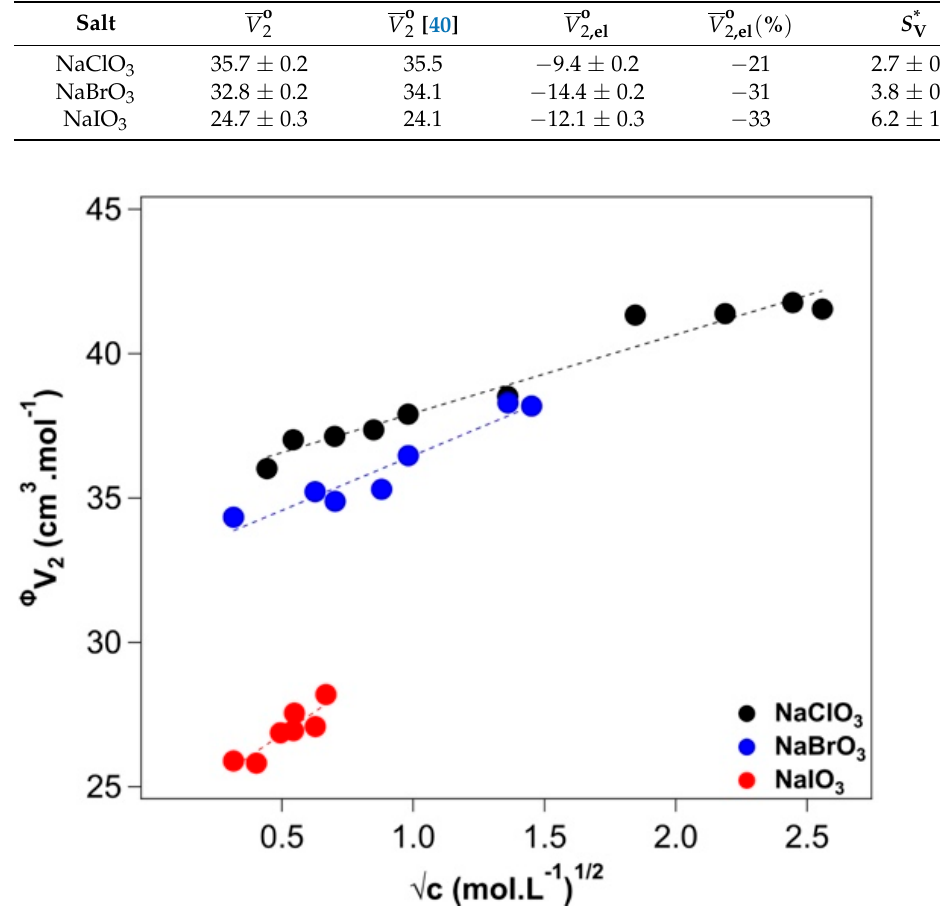
Figure 1. Linear fitting of the Masson’s equation (Equation (A5)). Sodium chlorate (black), bromate (blue), and iodate (red) solutions. The experimental error is ±1%.